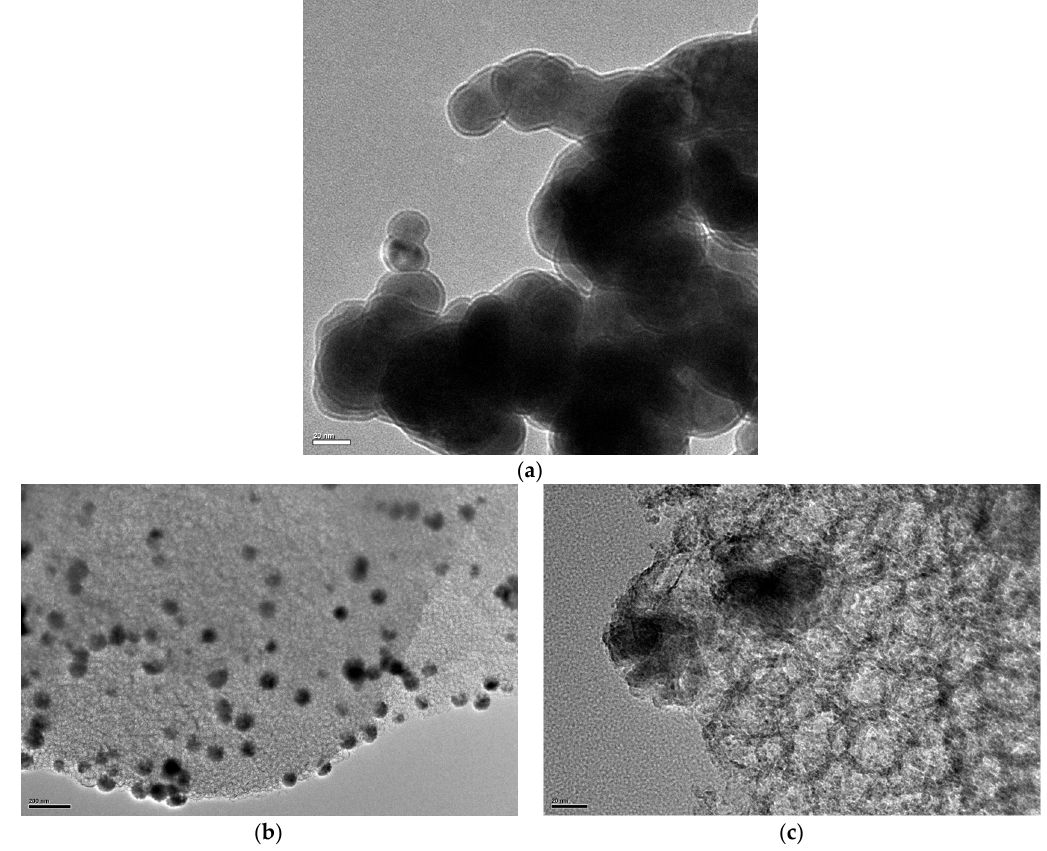
Figure 3. TEM images of bare Pd/Fe nanoparticles ( a ), and Pd/Fe nanoparticles supported on mesoporous silica ( b , c ). The scale bars are 20 nm ( a,c ), and 200 nm ( b ). A bare Pd/Fe nanoparticles with weight percentage of Pd to Fe at 0.30% is examined. For the supported Pd/Fe nanoparticles, weight percentage of iron to silica is 2.50%, and weight percentage of Pd to Fe is 0.075%.